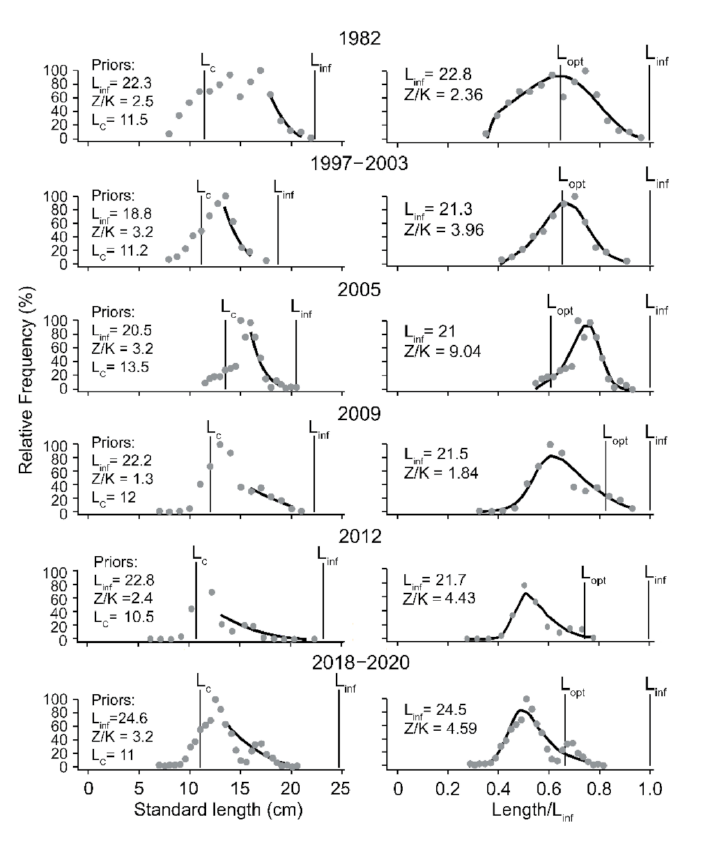
Figure 3. LBB estimation of C. mystus from the Yangtze River Estuary. The panels on the left show the length-frequency (L/F) data from which priors are estimated for L c , L inf , and Z / K . The panels on the right show the fit of the LBB master equation to the L/F data, which provides estimates of Z / K , M / K , F / K , L c , and L inf , with L opt computed from L inf and M / K .